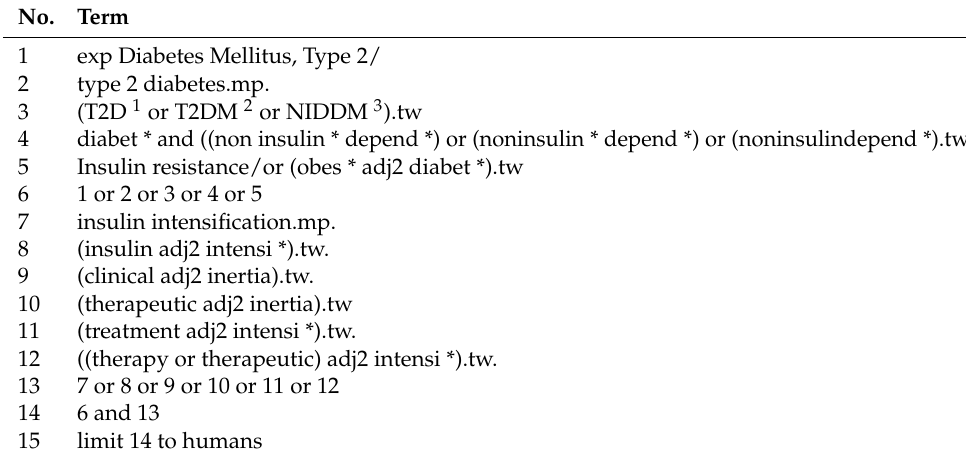
Table 1. Medical Subject Headings (MeSH) terms.